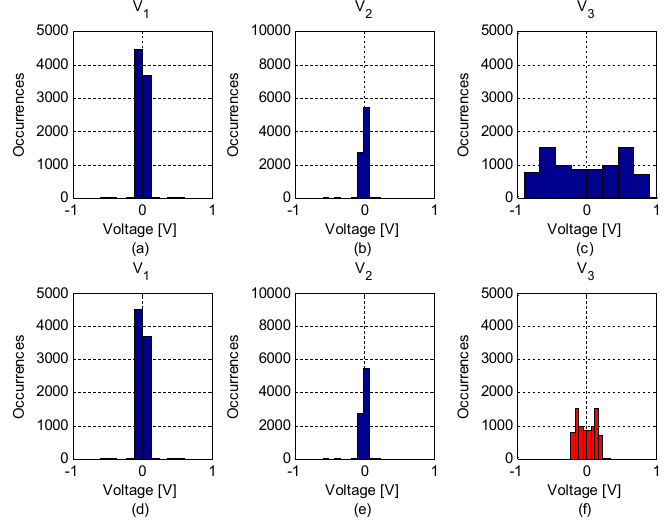
Figure 5. Comparison of each integrator’s output swing: ( a )–( c ) Histograms of the integrator output swing without gain scaling; ( d )–( f ) histograms of the integrator output swing with gain scaling.